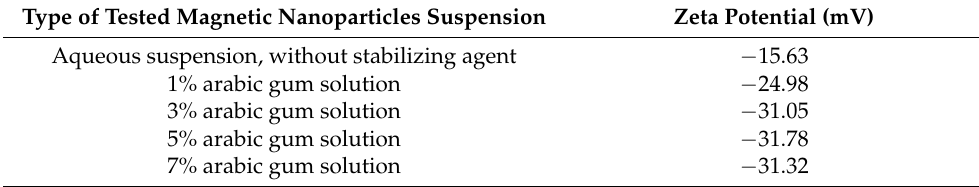
Table 1. Zeta potential measurements for various suspensions of magnetic nanoparticles. Type of Tested Magnetic Nanoparticles Suspension Zeta Potential (mV) Aqueous suspension, without stabilizing agent −